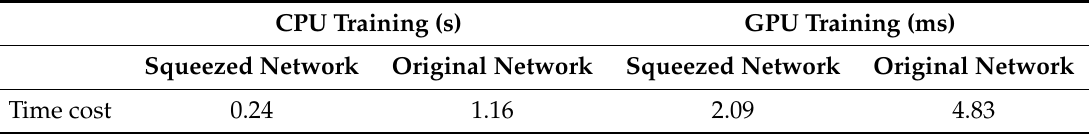
Table 3. Single sample inference time with squeezed network and original network in CPU and GPU.